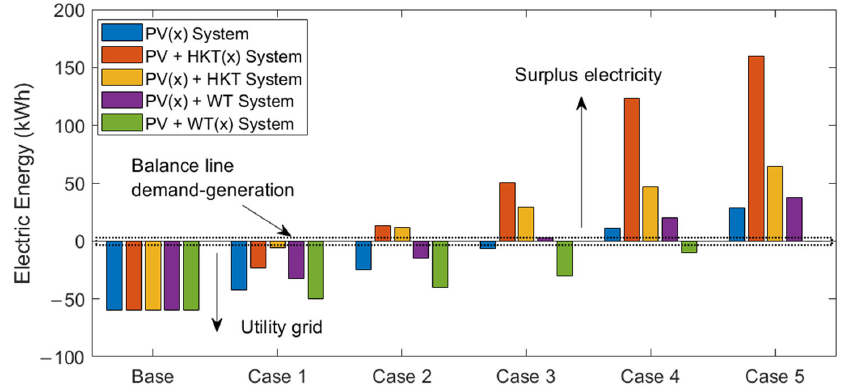
Figure 19. Energy exchange between HRES and the grid, sensitivity analysis of the proposed case studies.